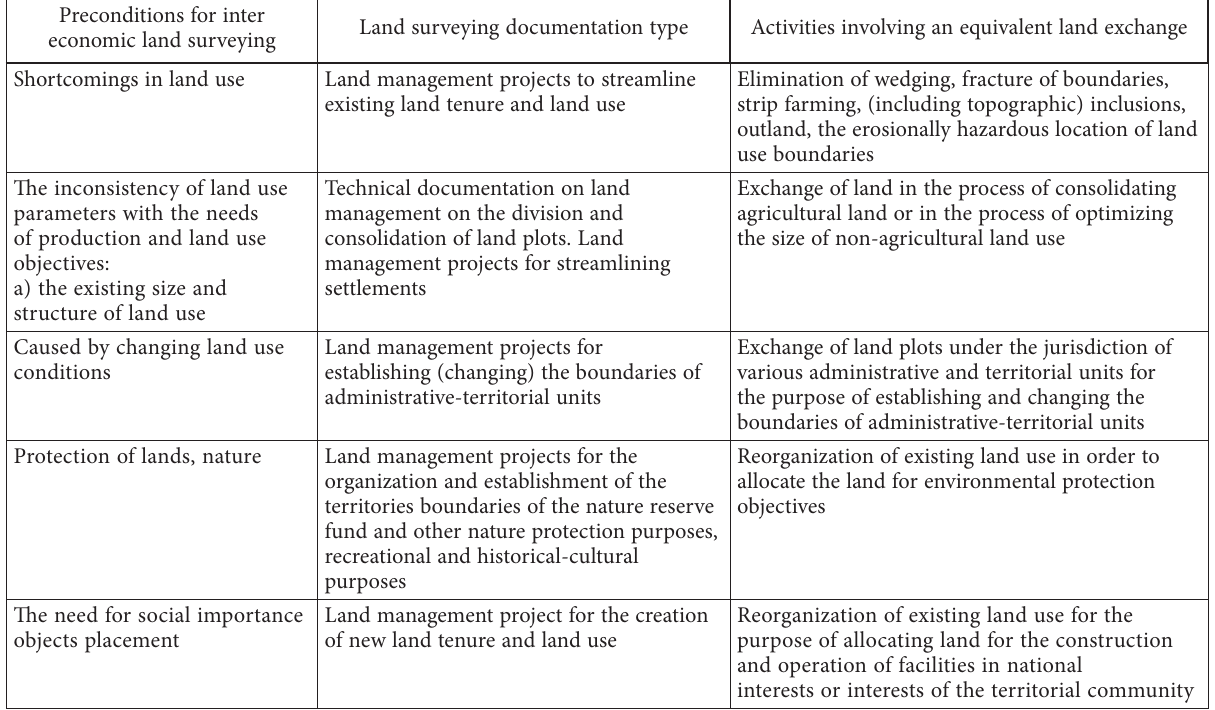
Table 1. Peer land exchange at land surveying in